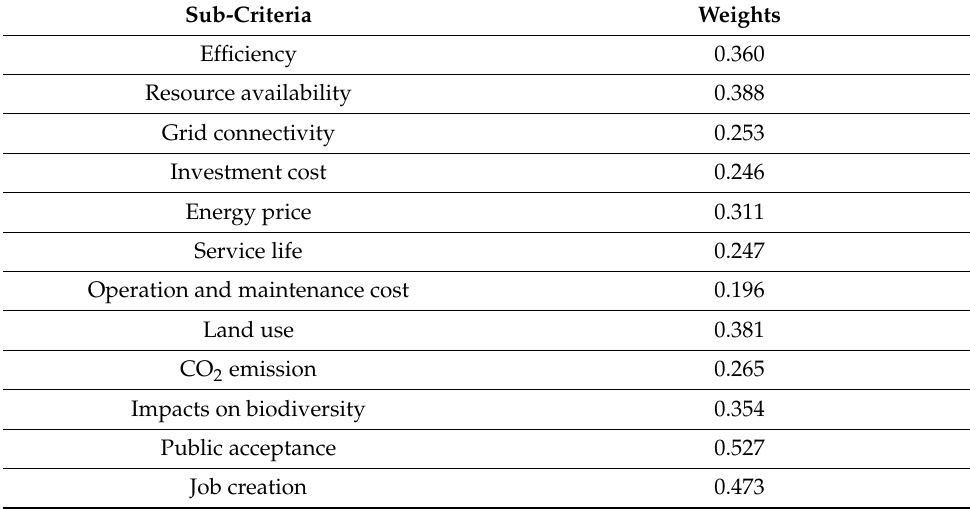
Table A2. Local weights of the sub-criteria of total respondents.